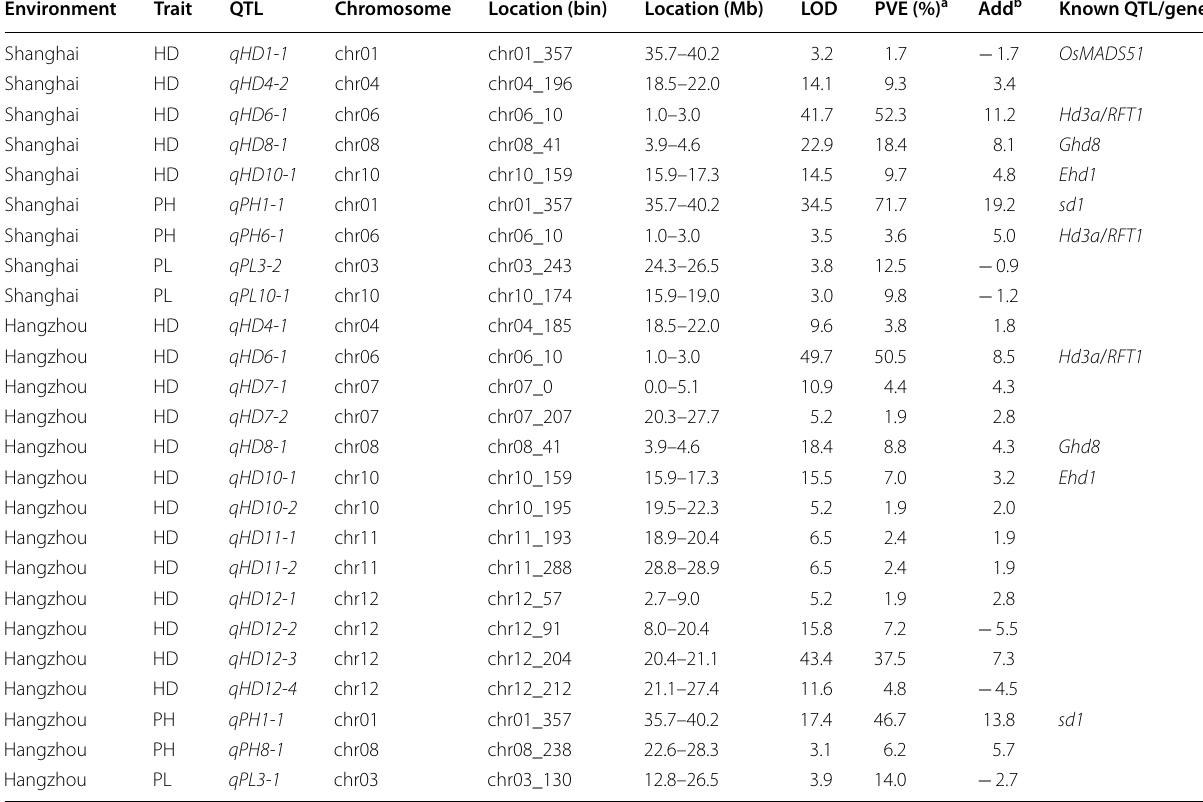
Table 3 QTLs for the three traits detected in the set of CSSLs in Shanghai and Hangzhou Environment